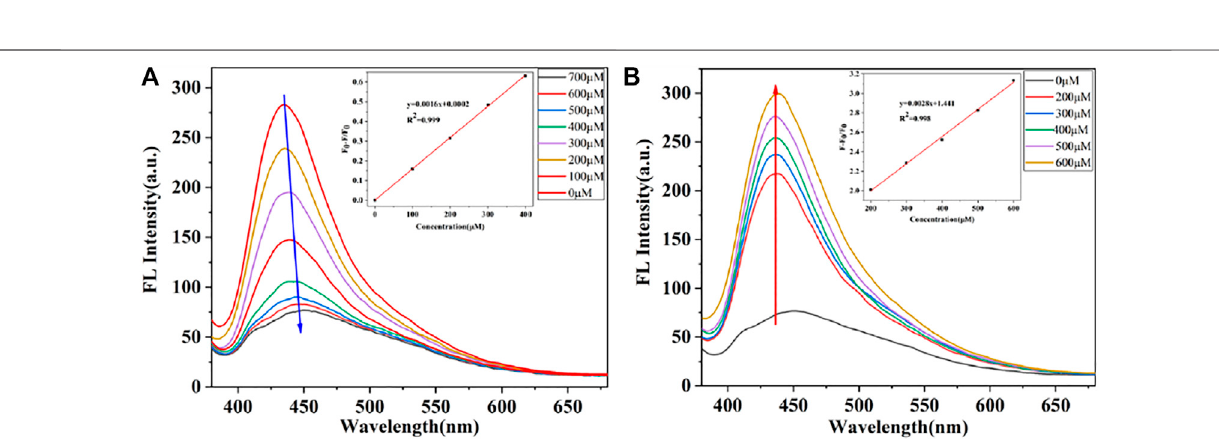
Frontiers in Chemistry |